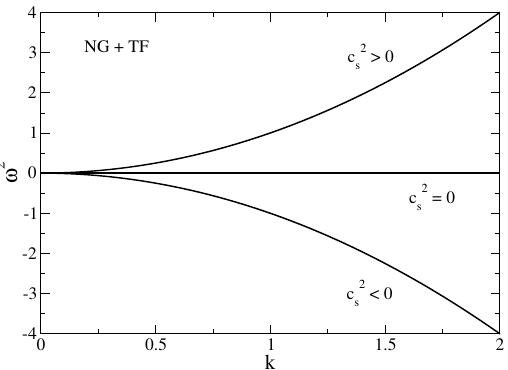
Figure 2. Dispersion relation for dissipationless BECs in the nongravitational + TF limit ( G = ¯ h =